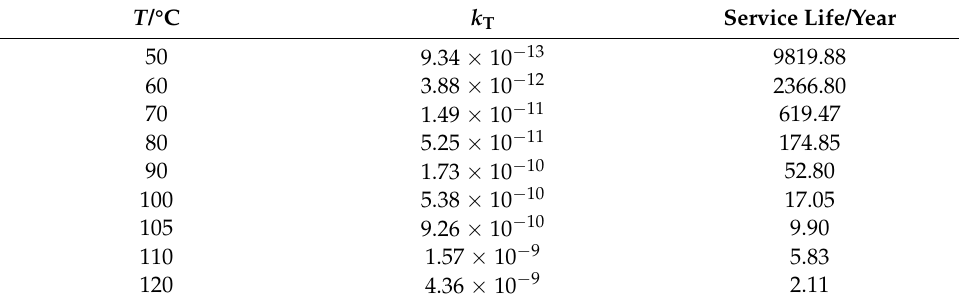
Table 4. Service life of the basin insulator at different